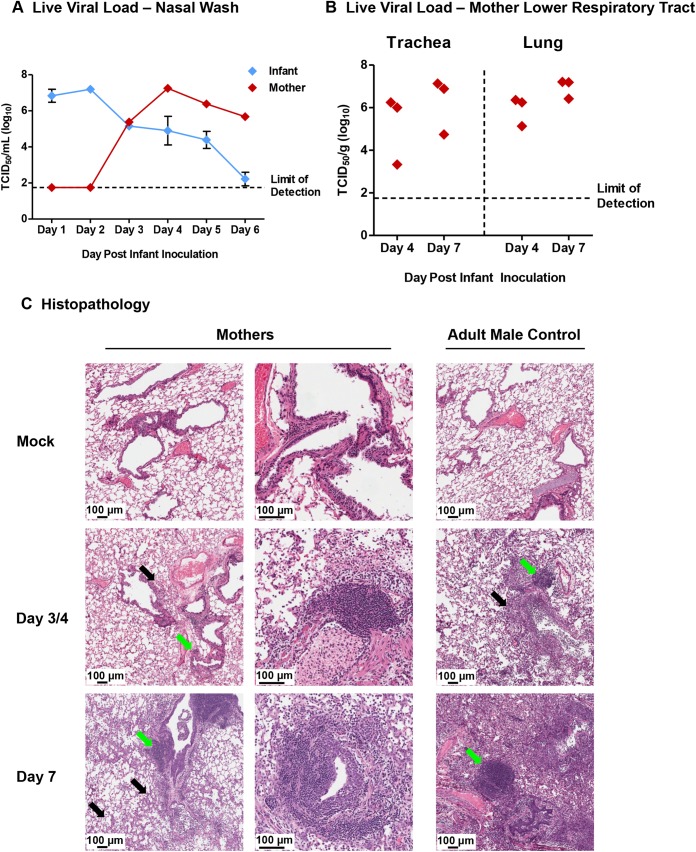
Transmission of H1N1 influenza from infants to mother ferrets causes upper and lower respiratory tract infection with significant pathology.Inoculated infants (A/Cal H1N1 influenza (105 EID50)) were housed with their nursing-mothers. Nasal washes were collected daily from infants and mothers. Live viral loads were determined by MDCK titration assay in nasal wash (NW) (A) and mother trachea and mother lungs at specific time points (B). Lungs were harvested on Day 3/4 and 7 post-infant-inoculation for hematoxylin & eosin (H&E) histopathological assessment from nursing-mothers of inoculated infants and directly inoculated adult ferrets as control (C). Green arrows denote dense cell accumulation; black arrows denote diffuse immune cell infiltration. Black arrows not included on Day 7 adult tissue due to widespread infiltration. High resolution scans were performed using an Aperio ScanScope XT, Leica Biosystems, Nußloch, Germany. The left and central columns of mother images represent a low and high magnification of each lung scan. The scale bars indicate the relative 100 μm. Results of A are representative of 3 independent litter inoculations where nasal washes were collected from 3 mothers and 9 infants (3 per litter) daily. Results of B and C are from 6 independent litter inoculations of serial tissue collections (3 collected Day 3/4 and 3 collected Day 7). Error bars indicate +/- SD. Mock: mother ferrets nursing mock-inoculated 4-week-old infant ferrets. Results show the mean or are representative of independent litter inoculations/infections.